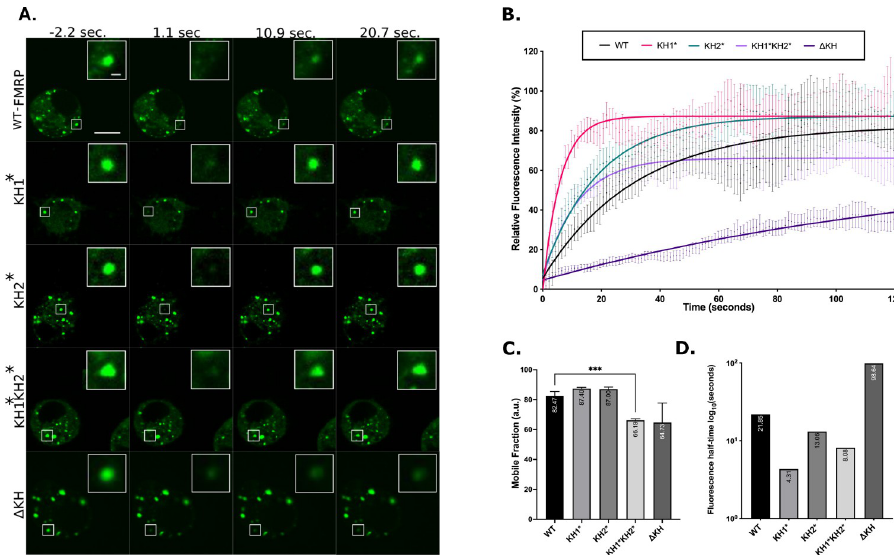
Fig 3. FXS-causing mutants alter FMRP granule dynamics in S2R+ cells. (A) Representative time-lapse FRAP images of FMRP-mutants pre- and post-bleaching. Scale bar in whole cell image = 5 μ m. Scale bar in zoomed-in granule image = 0.5 μ m. (B) Fluorescence recovery curves of FMRP-mutants over 120 seconds. Data points are mean ± SE. (C) Mobile fraction of FMRP mutant granules (mean ± SE; Brown-Forsyth test; ��� p < 0.001). a.u. = arbitrary units. (D) Quantification of the average time in log 10 (seconds), for granules to recover to half their final intensity (t 1/2 ). For B, C, and D n = 17–21